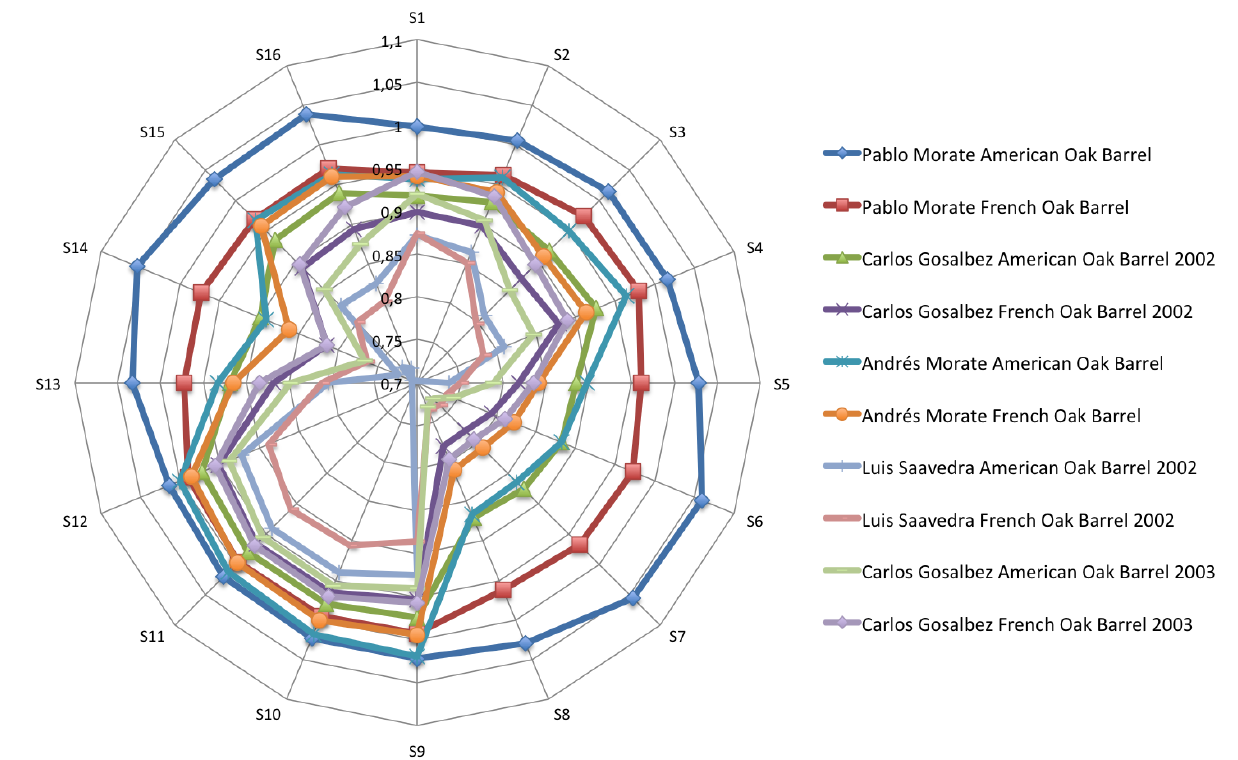
Figure 6. Polar pSlots of the variation in sensor resistance for the aged red